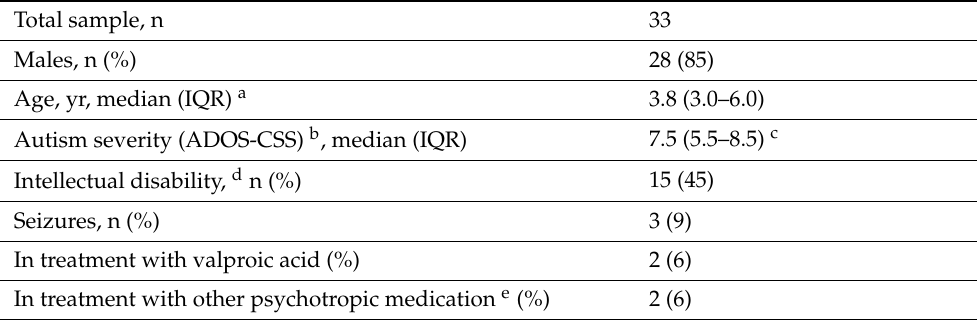
Table 1. Demographics and clinical characteristics of the autism spectrum disorder sample. Total sample, n